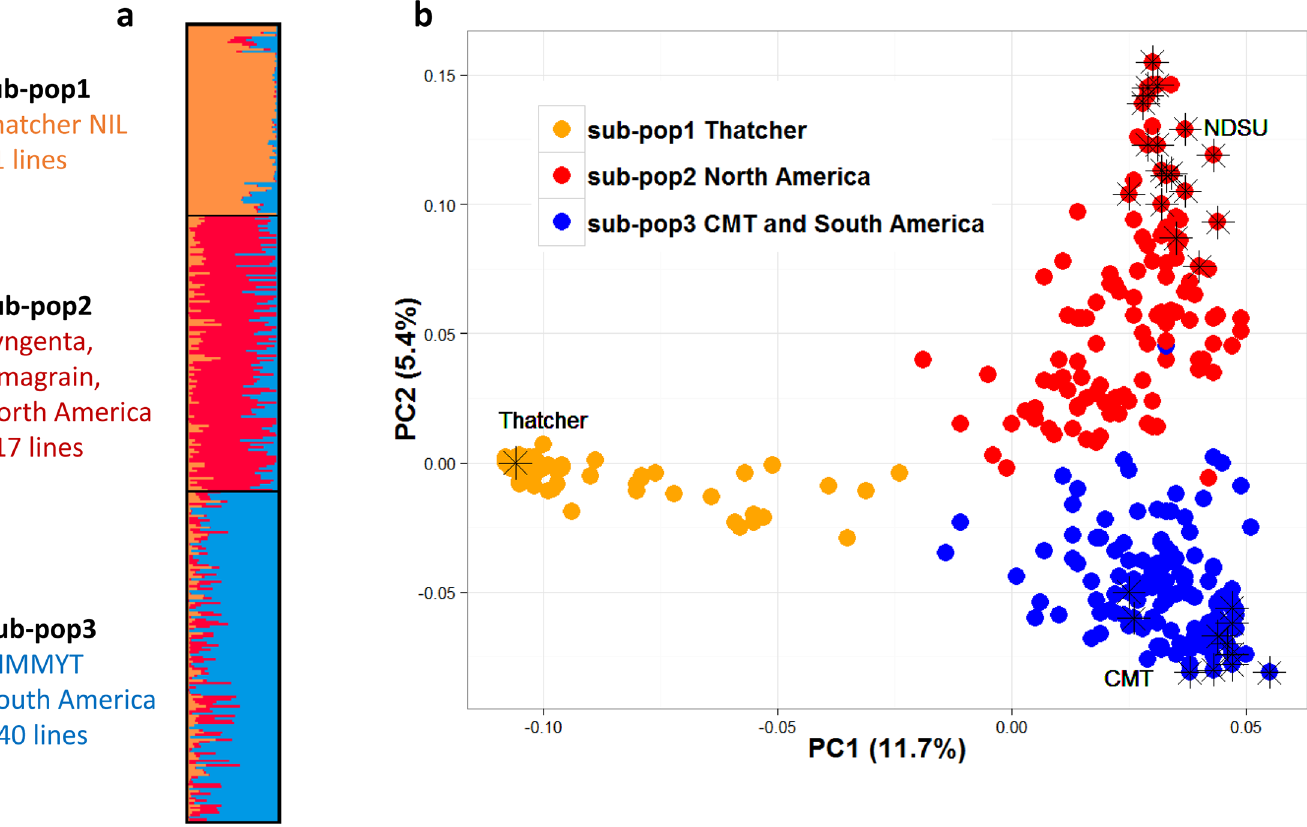
Fig 3. Population structure: model based approach and PCA approach. (a) model based approach for population structure analysis. (b) PCA approach for population structure analysis. Orange: sub-population 1; Red: sub-population 2; Blue: sub-population 3. Asterisks ( * ) on PCA plot indicate accessions that are typical of each sub-population. Sub-population 3 also has lines from North America. Both sub-pop2 and sub-pop 3 might include lines from Asia, Europe etc.